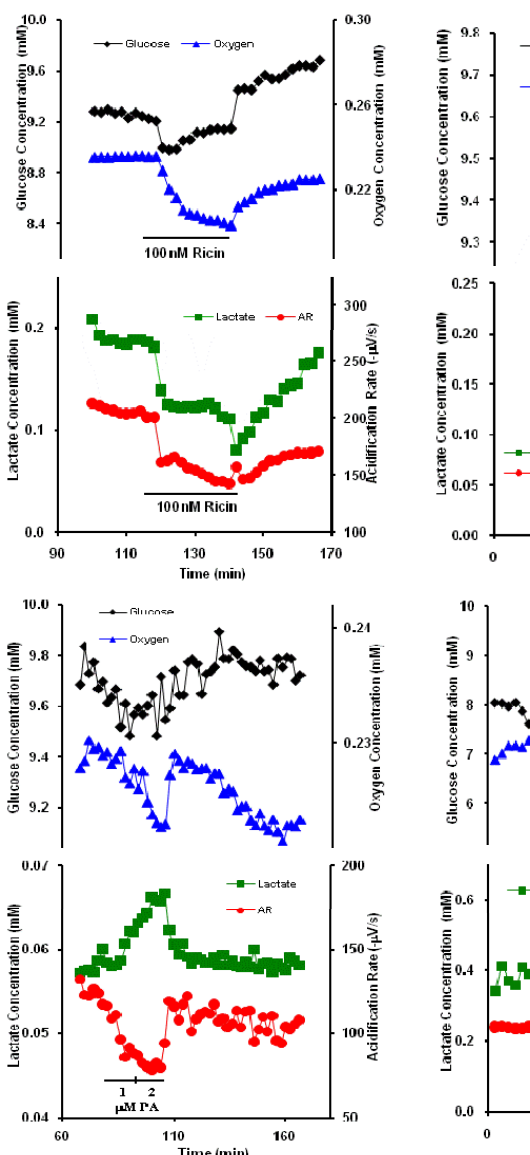
Figure 7. Combined representative metabolic profiles of all toxins for comparison in Figure